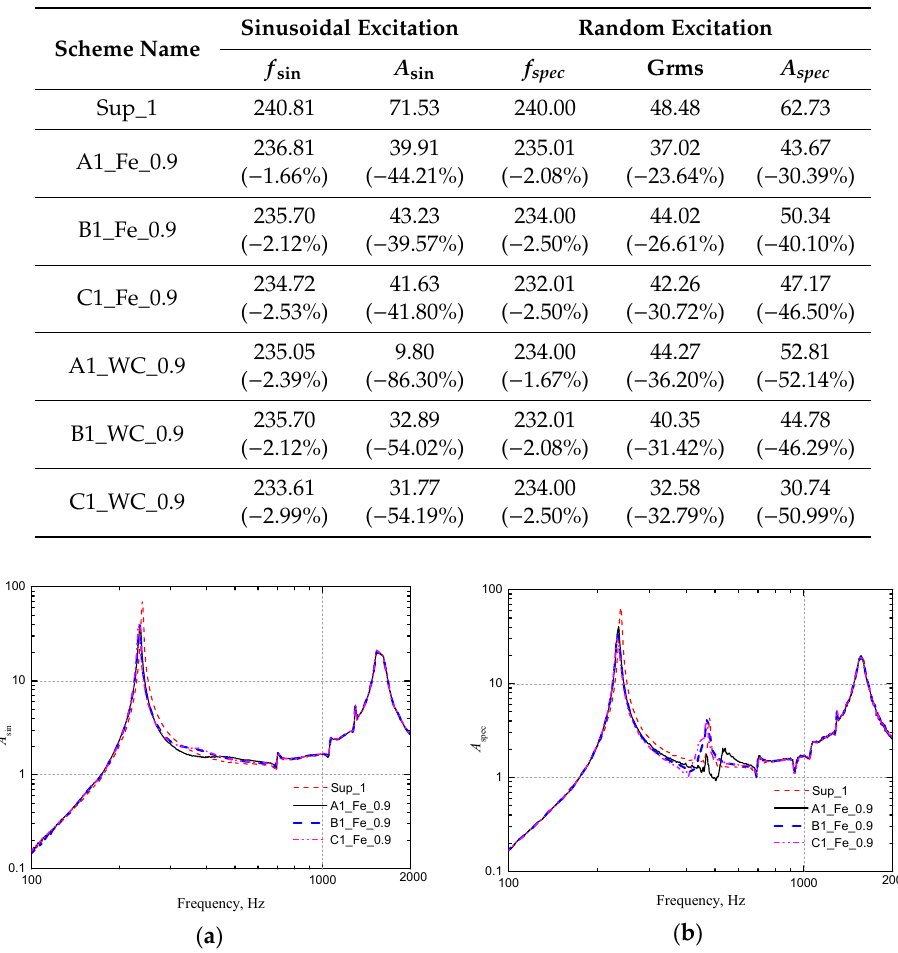
Figure 8. Experiment results of 2 mm stainless steel particle (layering in Z-direction of the cavity): ( a ) Sinusoidal excitation; ( b ) Random excitation.